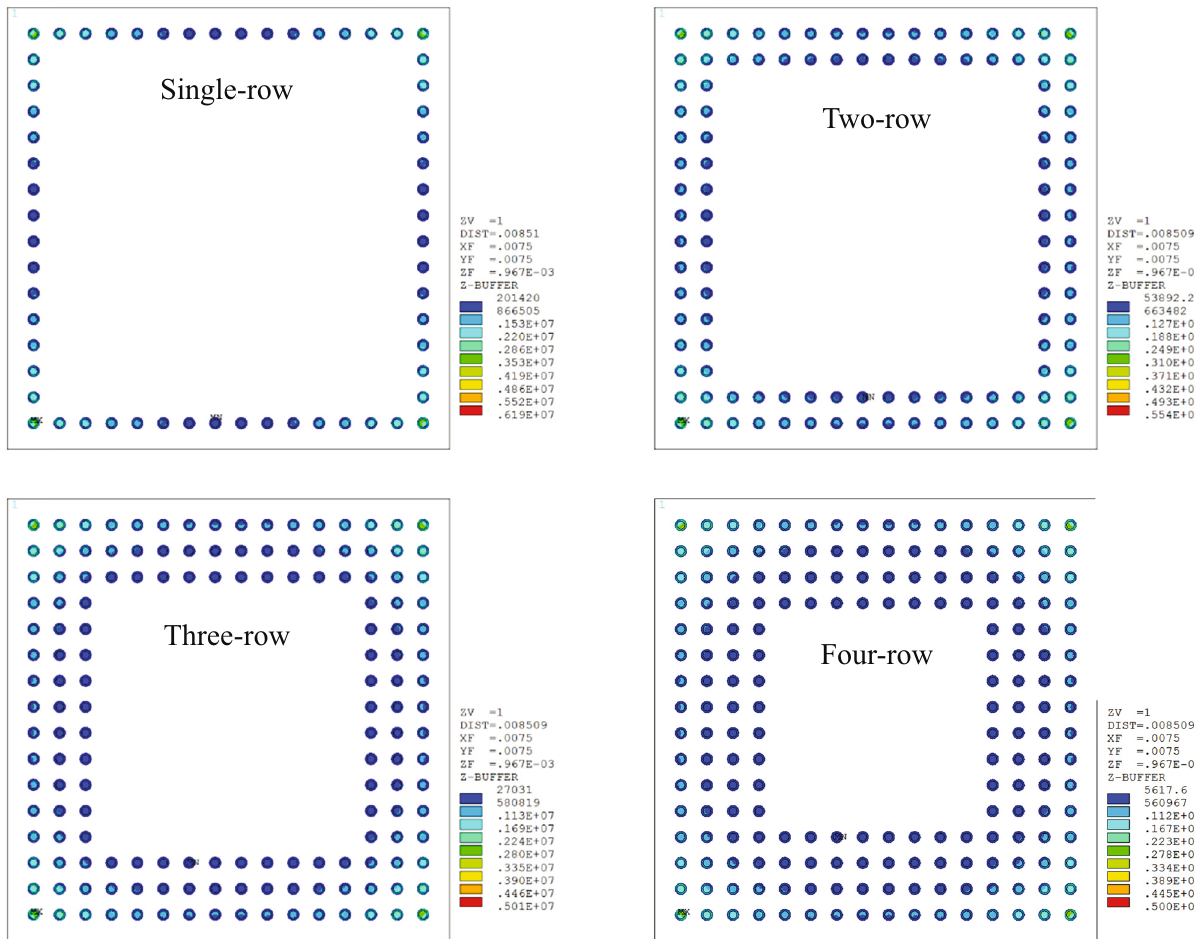
Figure 9: Von Mises stress distributions of the interconnect array in one - , two - , three - and four - row partial array con fi